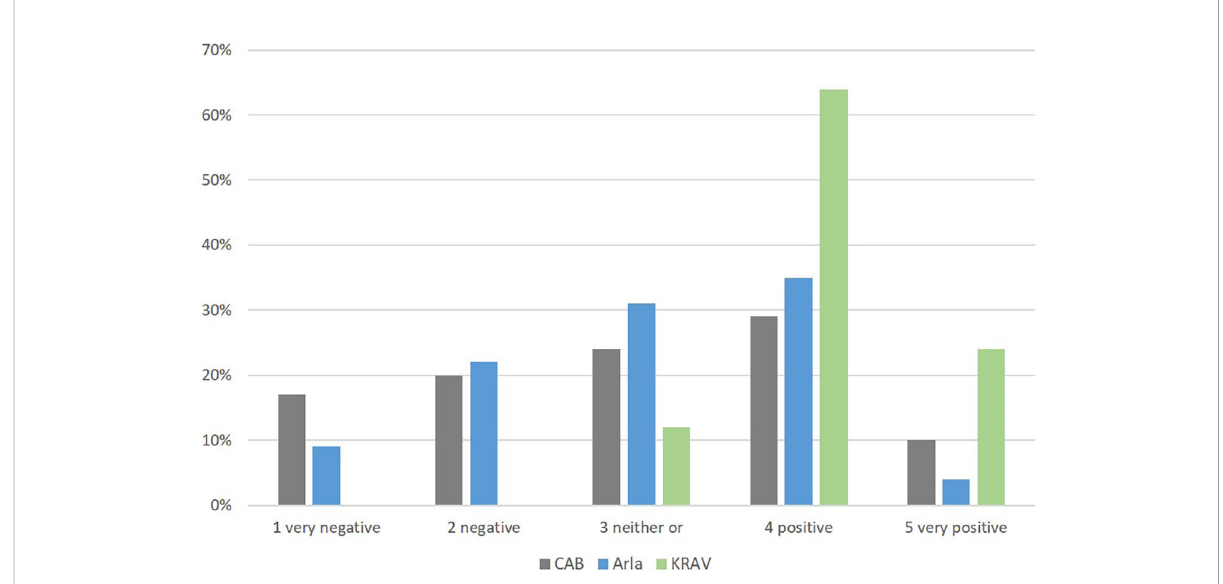
FIGURE 2 Dairy farmers perception of their latest inspection from CAB (n = 121, mean value 2.9), Arla (n = 55, mean value 3.0), and KRAV (n = 25, mean value